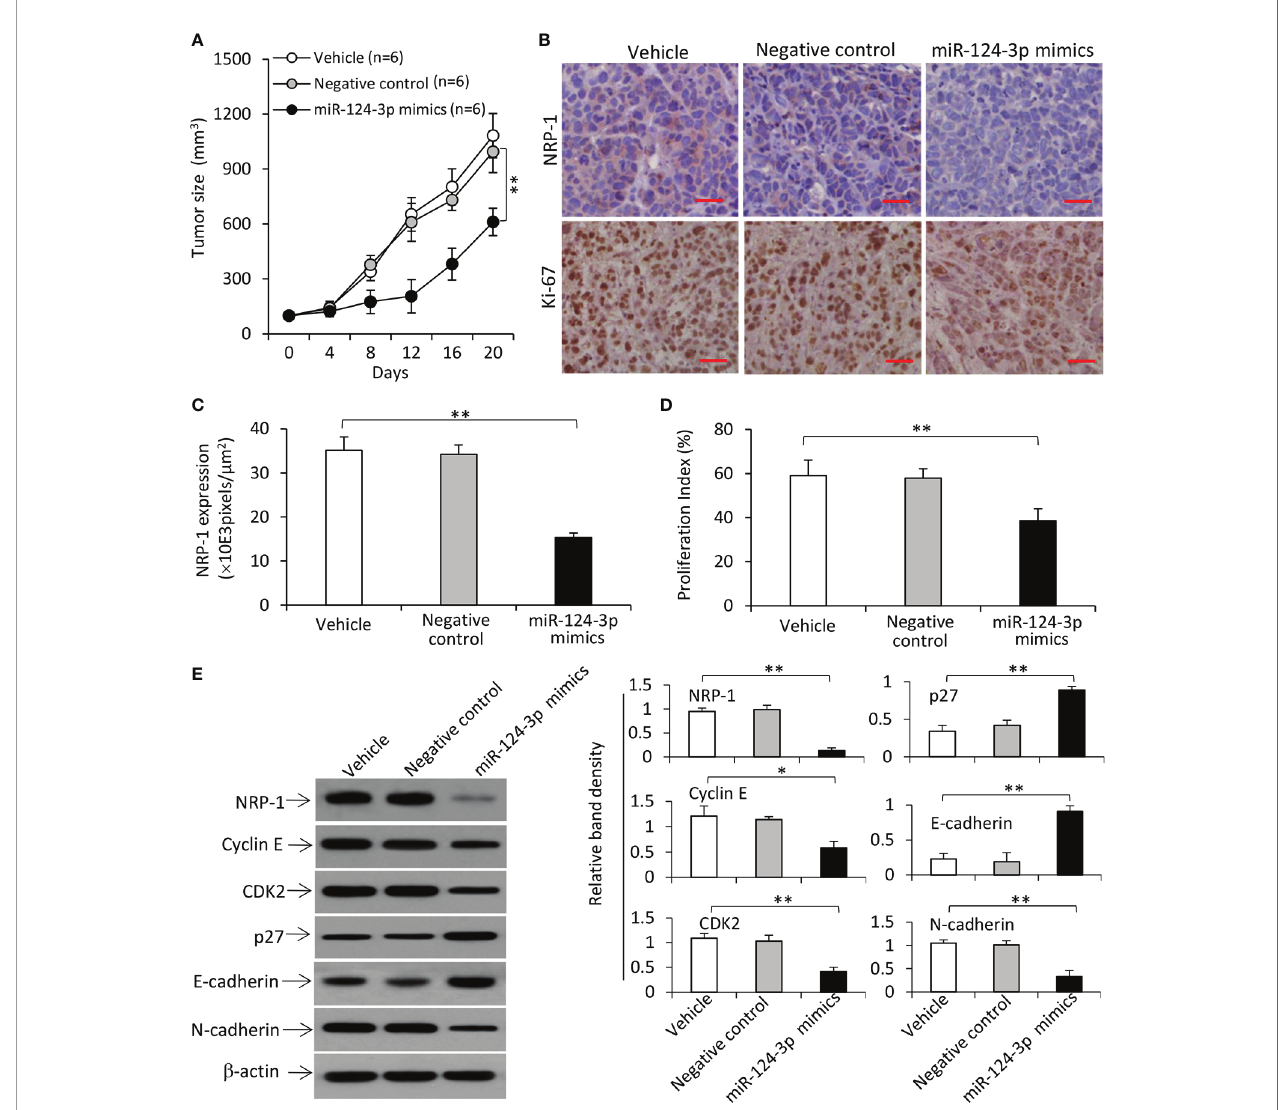
FIGURE 8 | Transfection of miR-124-3p mimics represses the growth of TNBC tumors by downregulating NRP-1 in mice. (A) MDA-MB-231 tumors were established in mice, which received intratumoral injections with vehicle, negative control or miR-124-3p mimics oligonucleotides when tumors reached ~100 mm 3 . (A) The growth curve of tumors was recorded. (B) Illustrated are representative tumor sections prepared 3 days following intratumoral injection, and immunostained brown with Abs against NRP-1 (upper panel) and Ki-67 (lower panel). Magni fi cation bar = 100 µm. (C) NRP-1 expression was expressed as pixels/ m m 2 as analyzed by ImageJ, and (D) the proliferation index was calculated by counting Ki-67-positive cells. (E) Tumor homogenates were subjected to Western blot analysis. Band density was normalized to b -actin. “ n ” , number of mice. “ *P < 0.05 ” ; “ **P < 0.001 ” (one-way ANOVA with a Tukey post-hoc